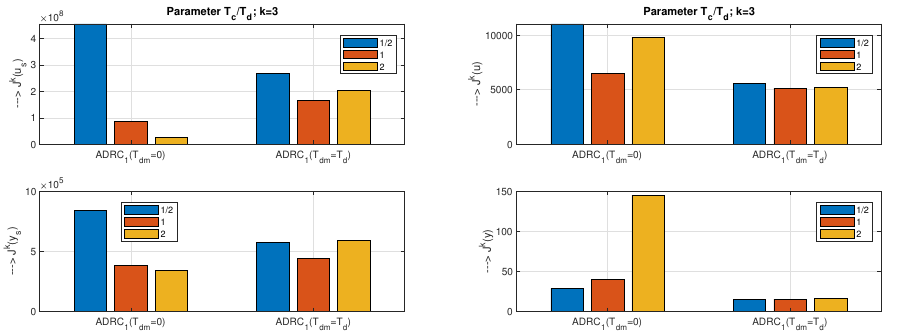
Figure 12. ADRC 1 controllers for T c = { 0.15,0.3,0.6 } with T dm = T d = 0 and T dm = T d = 0.3: Holistic cost functions (45) and (46) characterizing performance at the plant input and output for both setpoint and disturbance steps and k = 1 and k = 3.